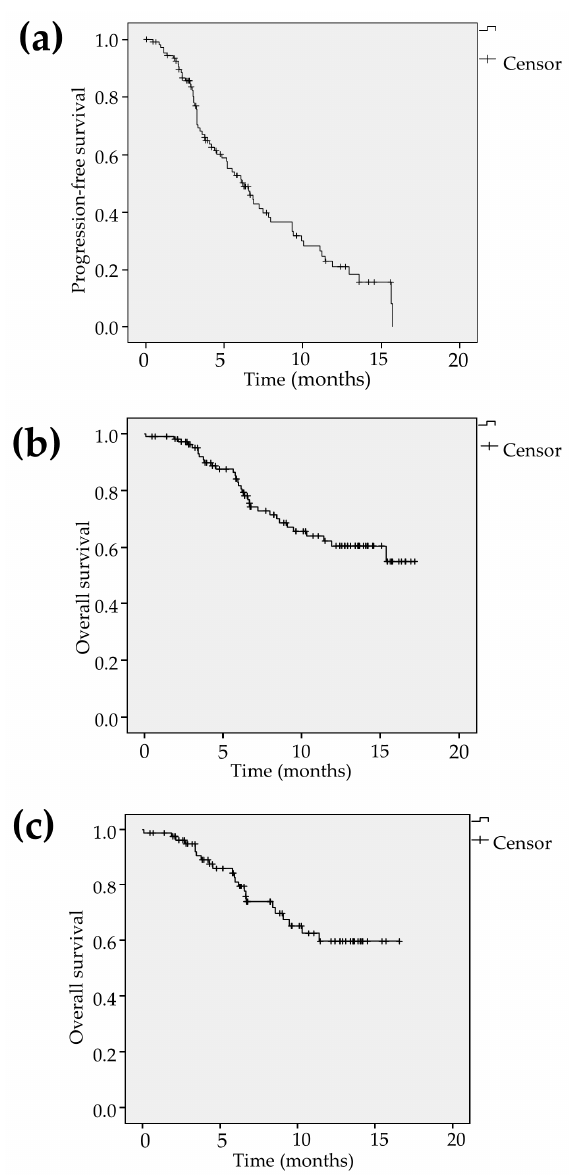
Figure 1. ( a ) Kaplan-Meier curve showed that the median progression-free survival (PFS) in all patients was estimated to be 6.3 months (95% confidence interval [CI] 4.7–7.8) and the PFS event were found in 68 patients (61.8%) at the time of analysis. ( b ) The 6- and 12-month overall survival (OS) rates were calculated to be 81.8% (95% CI 73.8–89.8) and 60.6% (95% CI 49.4–71.8) in all patients. The median OS was not reached during the observation. The OS events were observed in 33 patients (30.0%). ( c ) Among the patients treated with lenvatinib as the first-line treatment ( n = 84), the 6- and 12-month survival rates were shown to be 81.1% (95% CI 71.7–90.5) and 59.7% (95% CI 46.2–73.2) and the OS events were seen in 23 patients (27.4%).